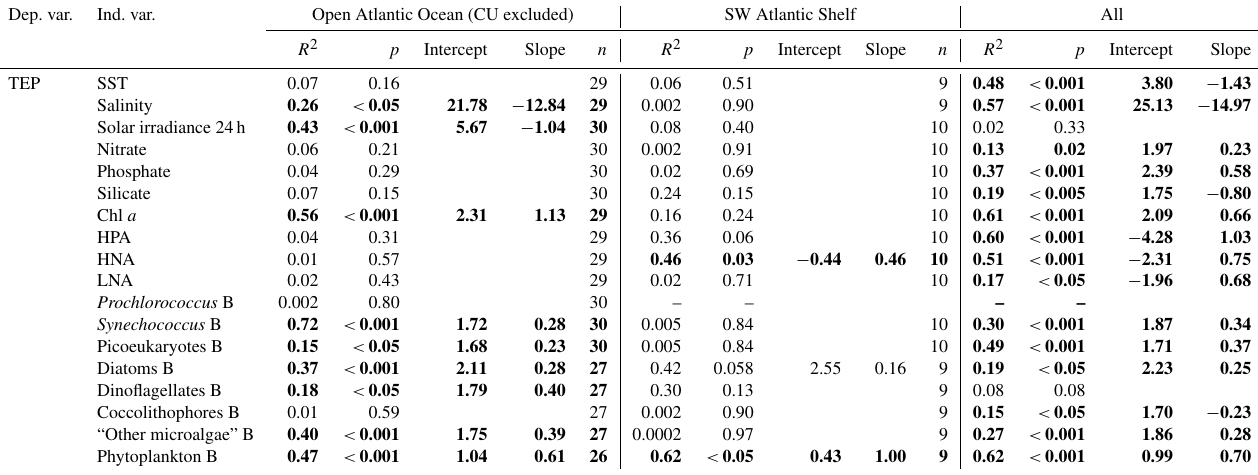
Table 3. Regression equations and statistics describing the relationship between TEP and different variables throughout the TransPEGASO cruise (note all variables were log 10 transformed). B = biomass. Bold font denotes statistical significance with p < 0 . 05. Dep. var. Ind. var.